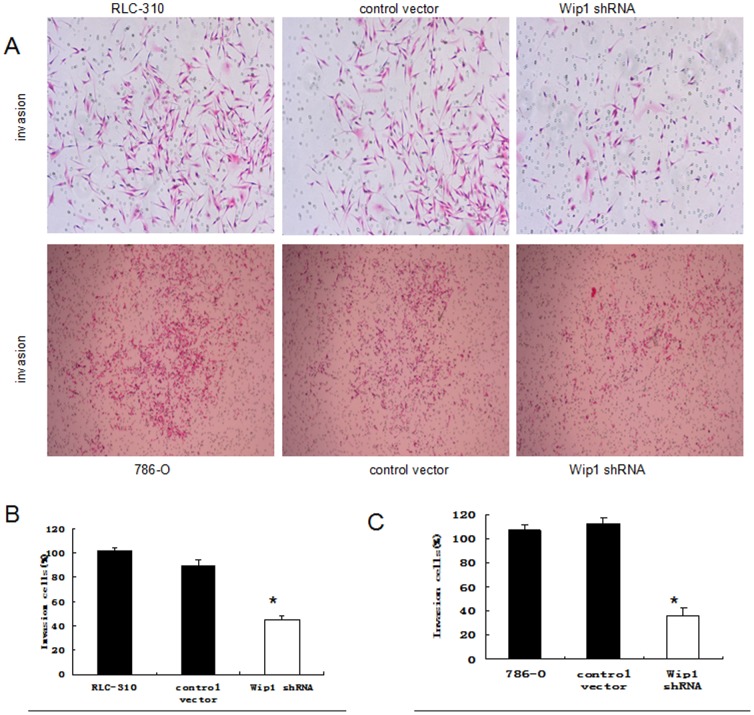
Wip1 knockdown inhibited the invasive ability of RCC cells in vitro.A, Representative images of the invaded 786-O and RLC-30 cells in Matrigel invasion assays were taken at ×200 magnification. B, C: Numbers of the invaded 786-O and RLC-30 cells per microscopic field. Data are presented as the means ± SD from three independent experiments. * p<0.05.